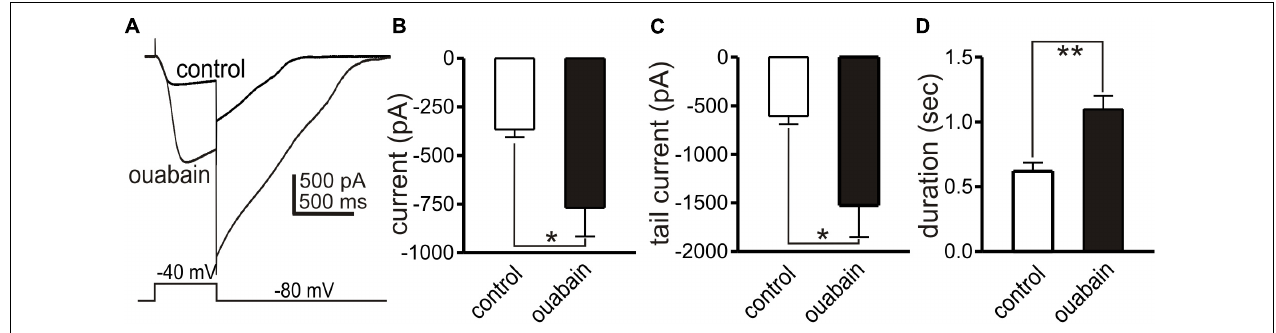
FIGURE 10 | Effects of ouabain on slow wave currents. Slow wave currents, activated by depolarizing steps from –80 to –40 mV, are shown in (A) before and in the presence of ouabain (200 nM). Ouabain increased the amplitude of the slow wave current, the amplitude of the tail current upon repolarization to –80 mV and the duration of the tail current. Summarized data from five experiments are shown in (B–D) , respectively. * p < 0.05, ** p <